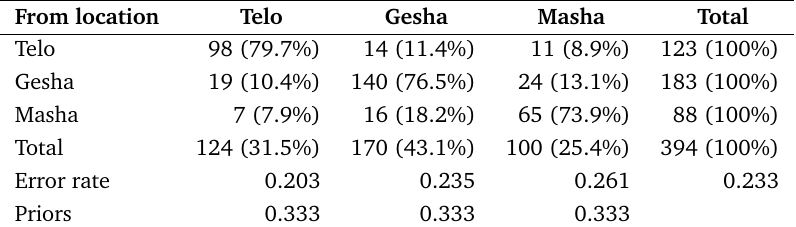
Table 12. Number and percentage of observations classified into locations.